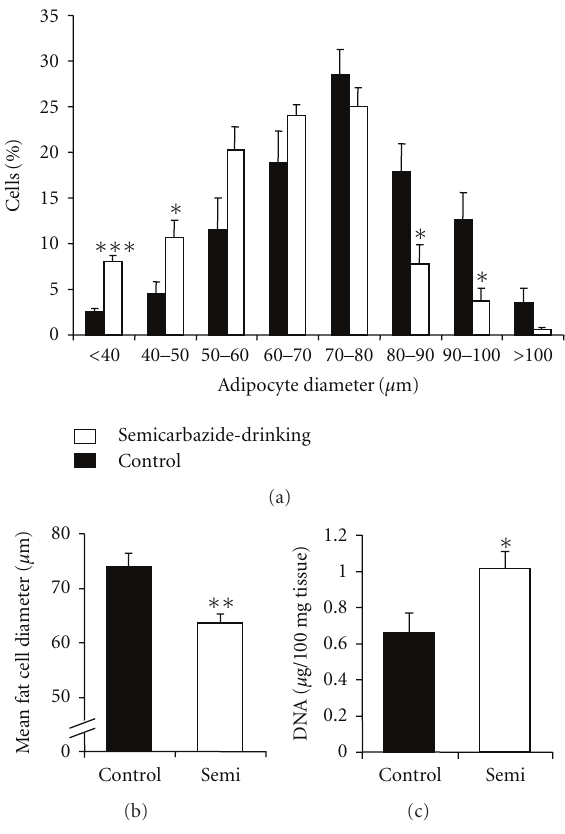
Figure 3: E ff ect of chronic semicarbazide ingestion on the cellularity of visceral adipose tissues. Adipocytes isolated from visceral adipose tissues were subjected to size analysis and counted according to the indicated distribution of cell diameter classes (a). Mean fat cell diameter was calculated (b) while DNA was extracted from pieces of visceral WAT and determined as described in Section 2 (c). Mean ± SEM of six mice per group. Di ff erent from control at ∗ P < . 05, ∗∗ P < . 01, ∗∗∗ P < .